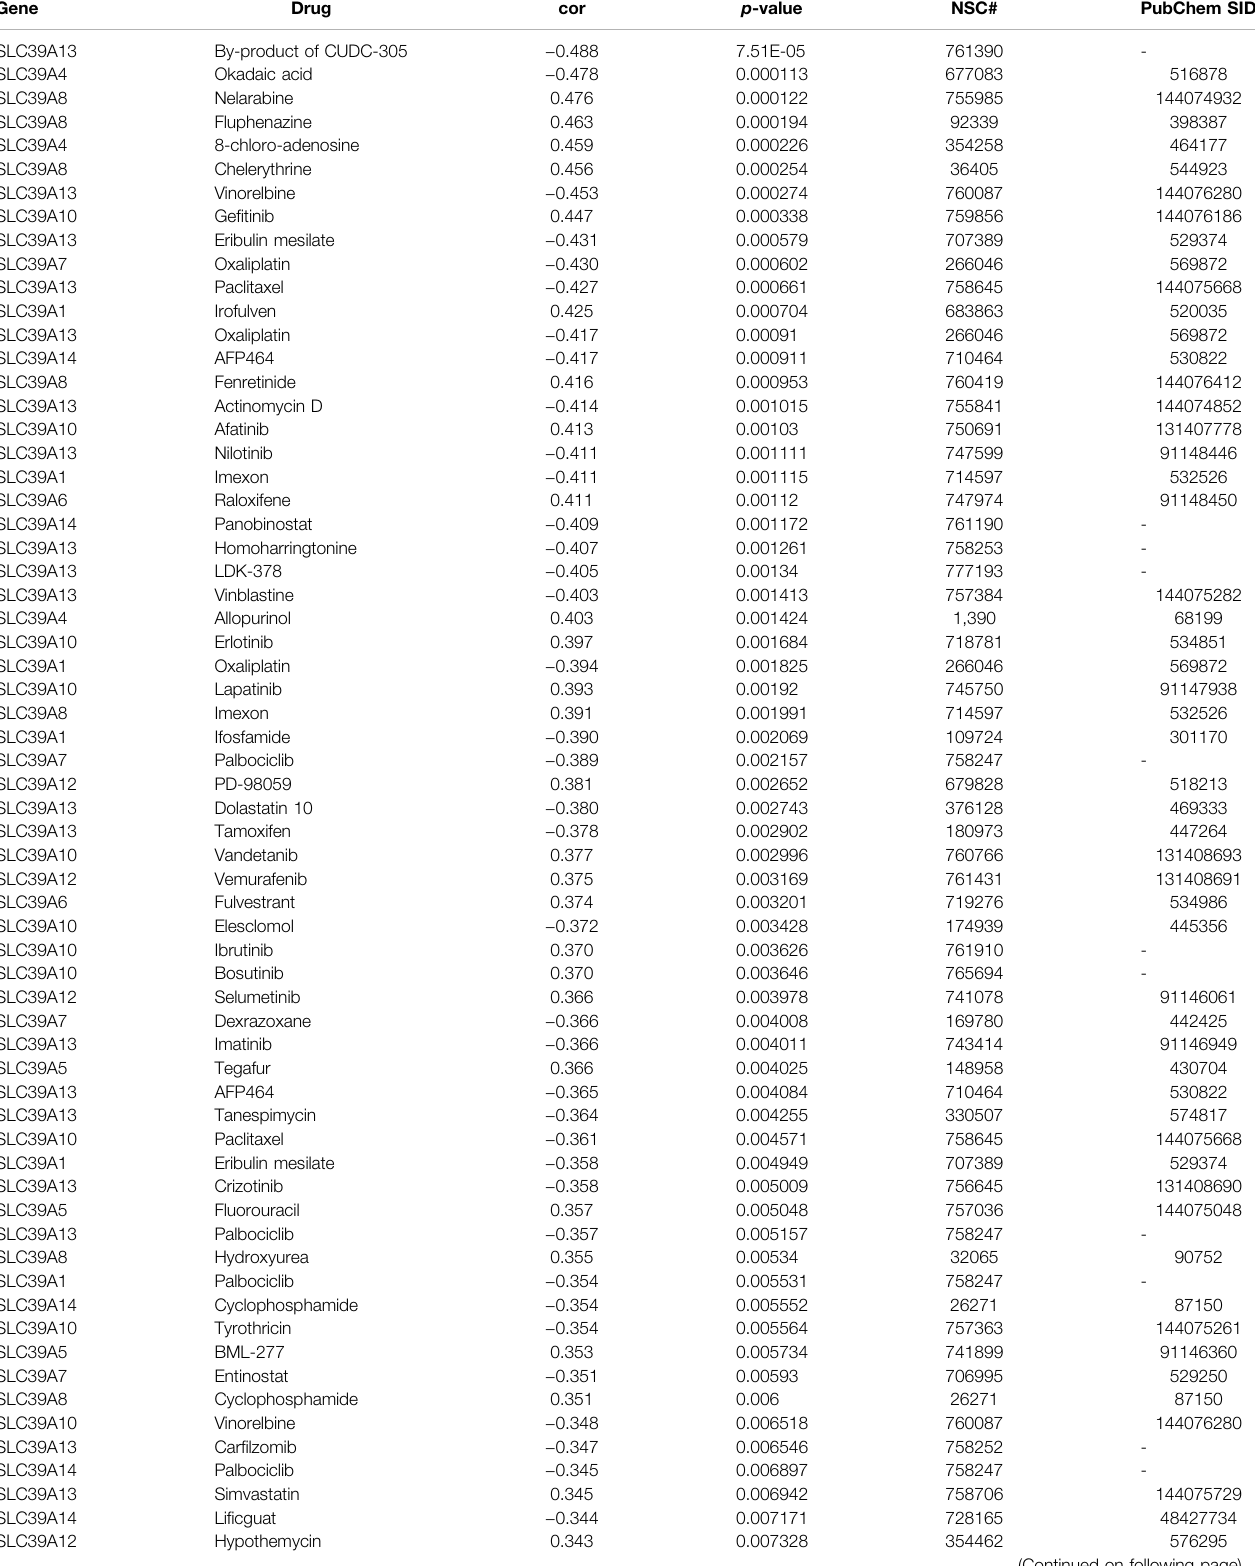
TABLE 2 | Relationship between SLC39A family gene expression and drug sensitivity based on the NCI-60 cell line.